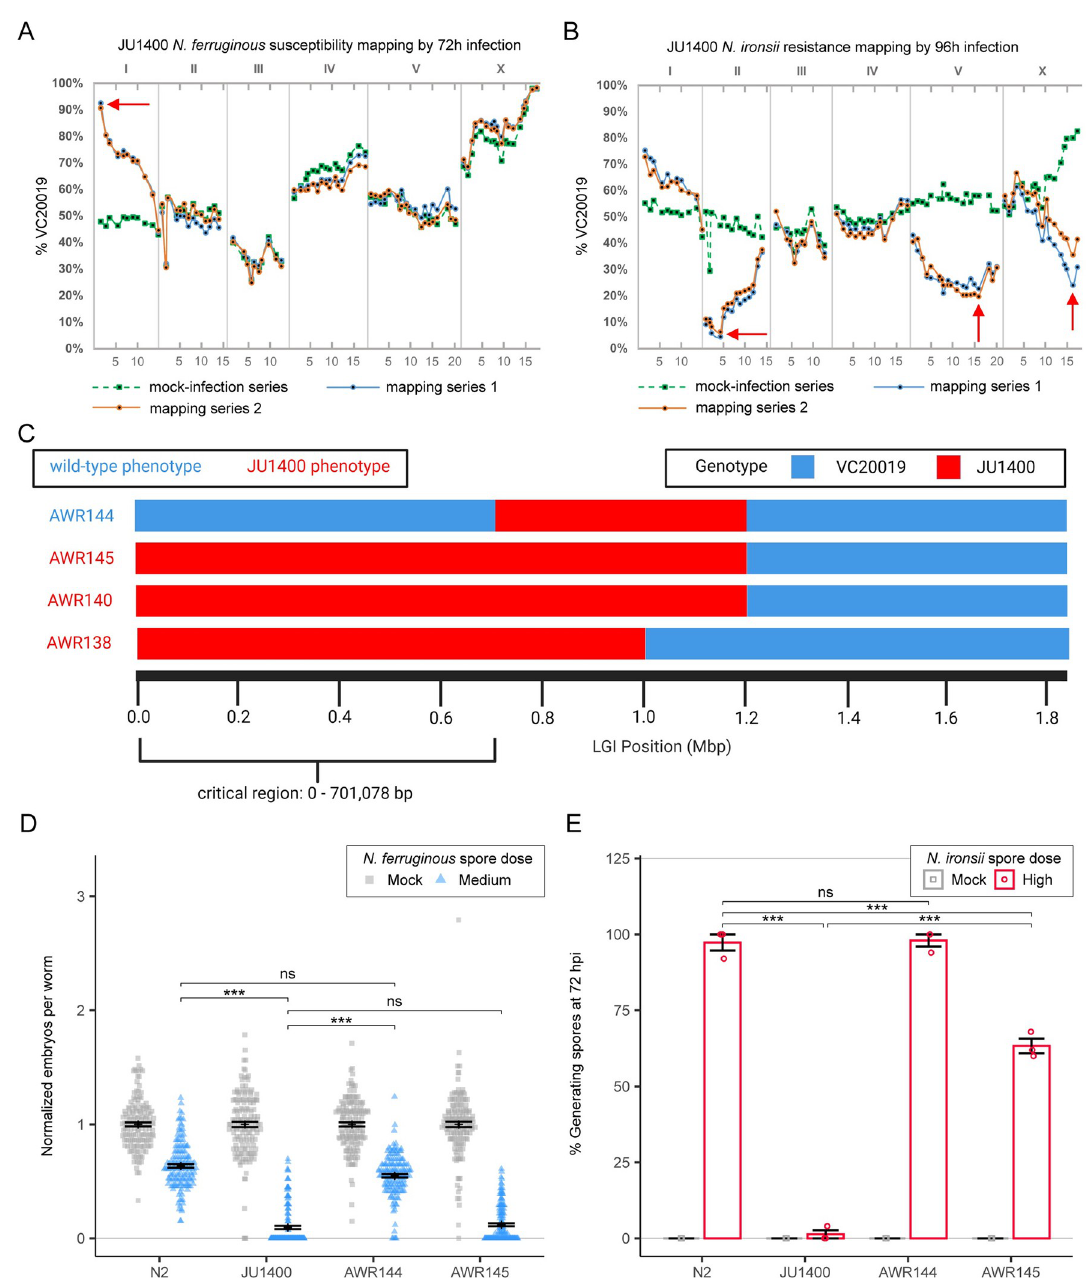
Fig 6. Genetic mapping of JU1400 host-response phenotypes identifies distinct loci. Genetic mapping of JU1400 susceptibility to N . ferruginous (A) and JU1400 resistance to N . ironsii (B) was performed with MIP-MAP using the AWR133 mapping strain. Green square-points and dotted lines represent a mock-infection replicate with the solid blue and orange lines representing two biological replicates exposed to specific infection conditions. Red arrows indicate candidate regions of interest based on the expected genome fixation direction during phenotype selection. (C) Whole-genome sequencing haplotype map of chromosome I NILs generated from crosses between JU1400 and AWR133. Regions of chromosome I for specific NILs are coloured by their inferred haplotype. Strain names are indicated to the left of each with AWR138, AWR140, and AWR145 sharing a susceptibility phenotype (Red text) while AWR144 is not susceptible (Blue text) to N . ferruginous infection. (D) N2, JU1400, AWR144, and AWR145 L1 stage animals were infected with N . ferruginous before being fixed at 72 hpi and stained with DY96 to visualize embryos. Dot plot of normalized embryo counts with mean and SEM bars. Data is combined from three biological replicates with n = 50 worms per replicate sample. (E) N2, JU1400, AWR144, and AWR145 L1 stage animals were infected with N . ironsii before being fixed at 72 hpi and stained with DY96 to visualize mature spores. Bar plot with SEM bars show percent of animals generating new spores per replicate from three biological replicates with n = 50 worms per replicate. p-values were determined by two-way ANOVA with Tukey post-hoc. Significance was defined as p � 0.001 ( ��� ) and not significant as p > 0.05 (ns).